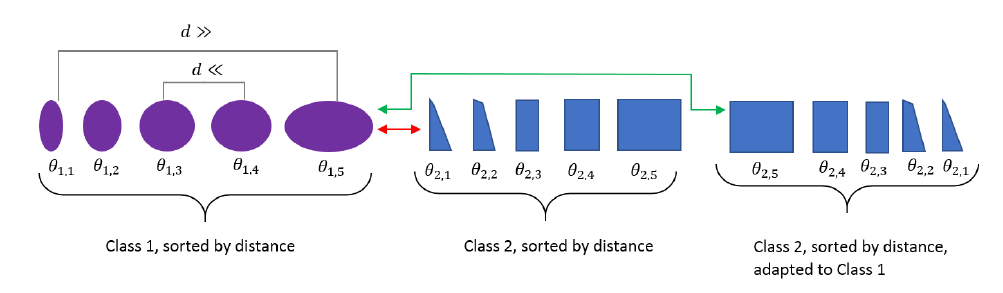
Figure 10. Sorting of shapes along a morphing circle. Left: arrangement of class elements θ i , k by using Euclidean distances. Middle to right: reversing the order of elements to achieve matching boundaries between